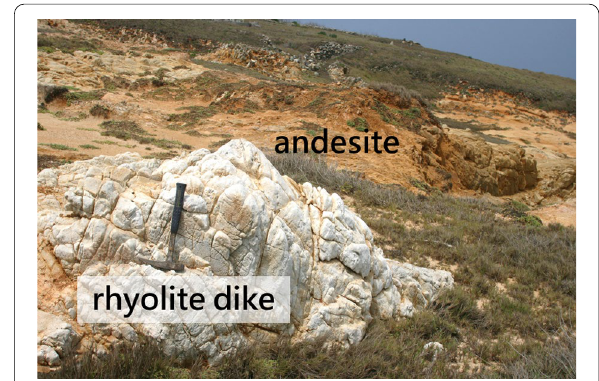
Fig. 3 A photo demonstrating the weathering resistance of dikes in